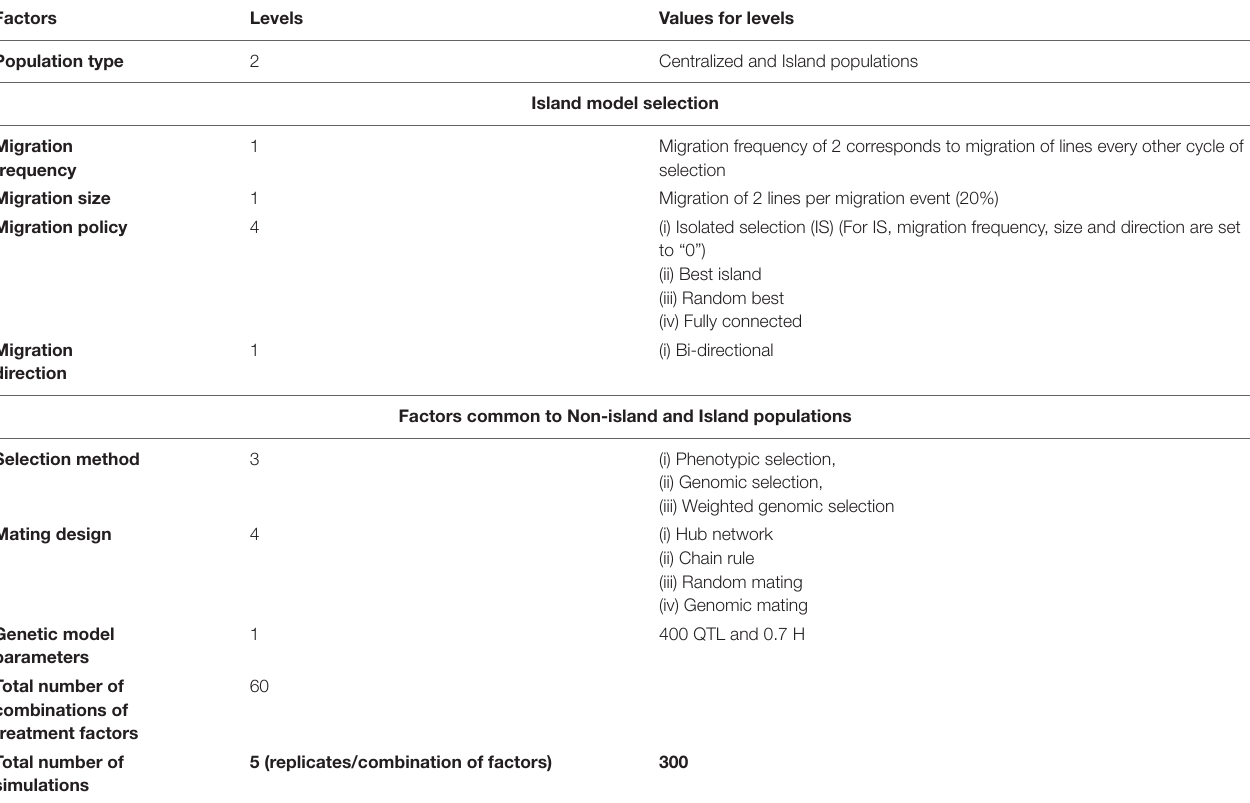
TABLE 1 | Treatment design representing the factors that impact responses and limits of responses that were